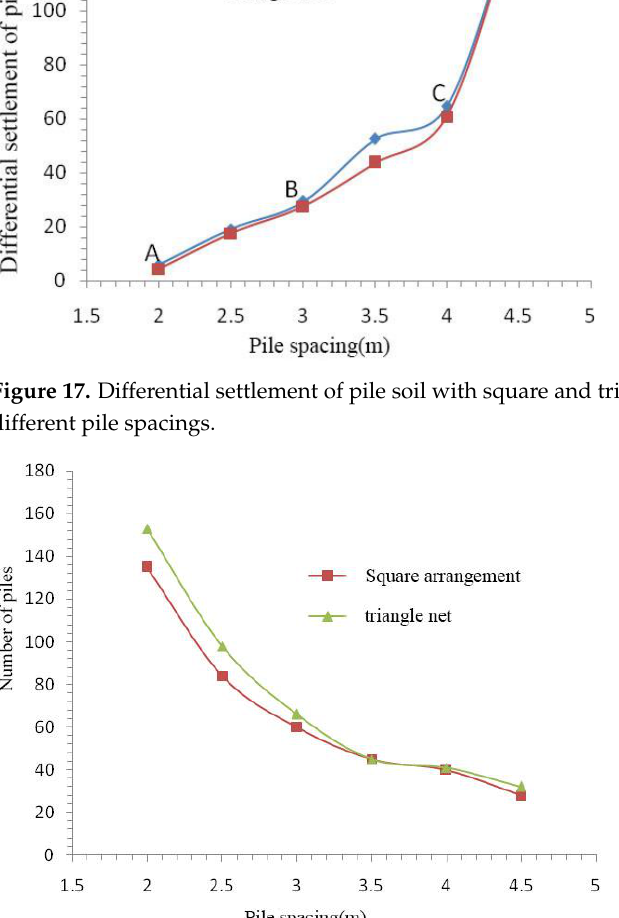
Figure 18. Number of required piles for a GRPSE with square and triangle net arrangements and different pile spacings.